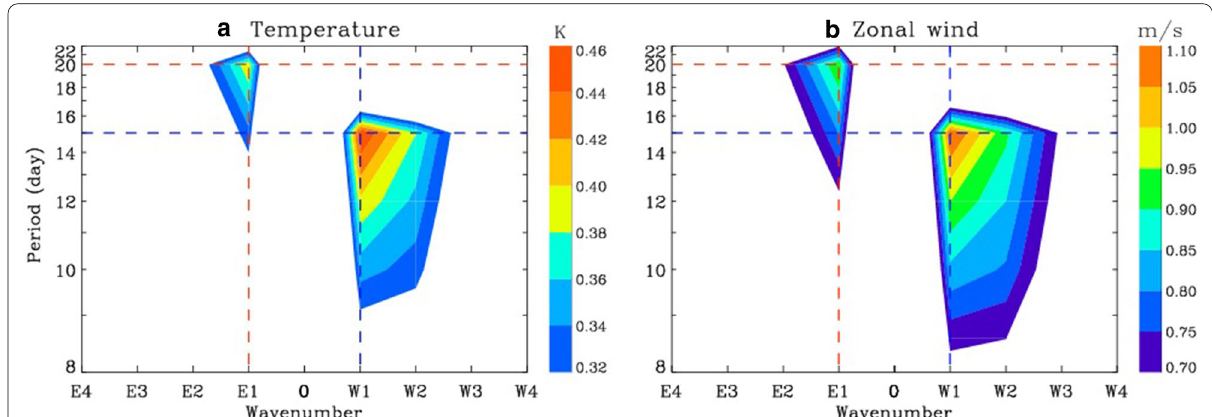
Fig. 1 Mean frequency-wavenumber spectrum of ( a ) temperature and ( b ) zonal wind from February 1979 to January 2018 (39 years in total) at 37 pressure levels from 1000 to 1 hPa. W (E) represents westward (eastward)